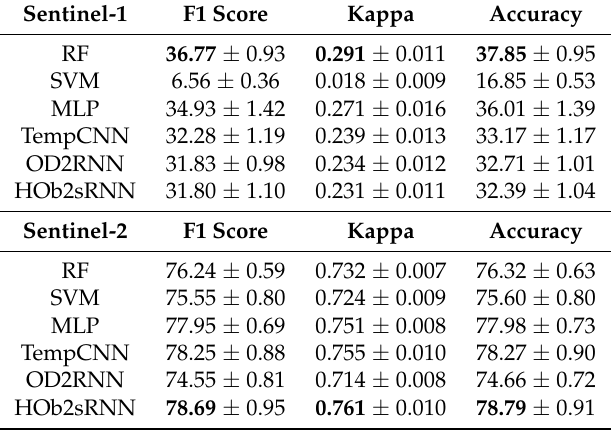
Table 6. F1 score, Kappa, and Accuracy of the different methods considering the per-source ablation analysis on the Reunion island (results averaged over ten random splits). We have highlighted the best scores in